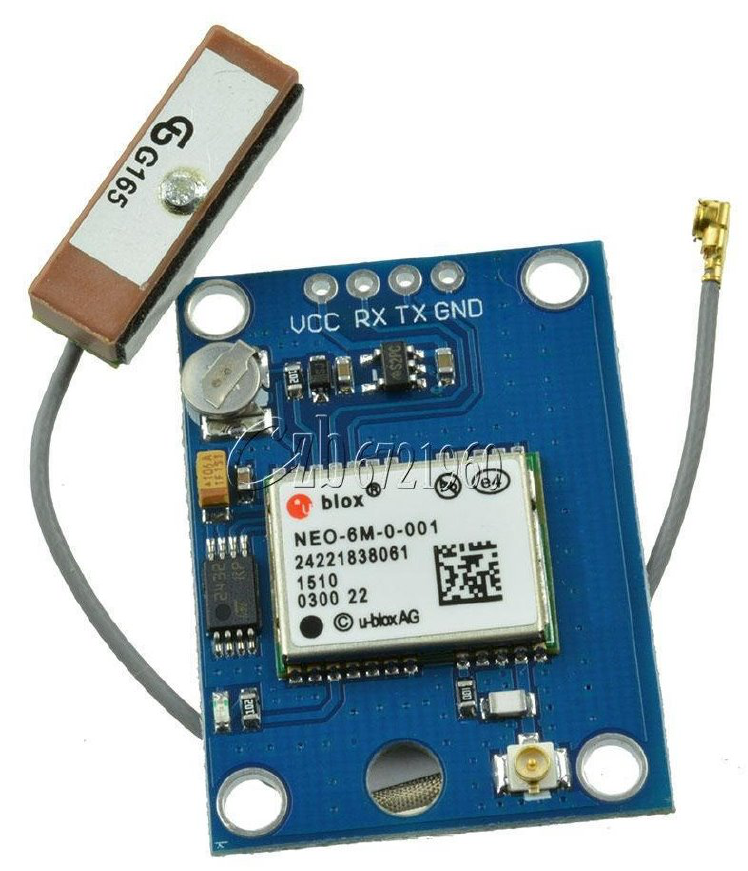
Figure 10. GY-GPS6MV2